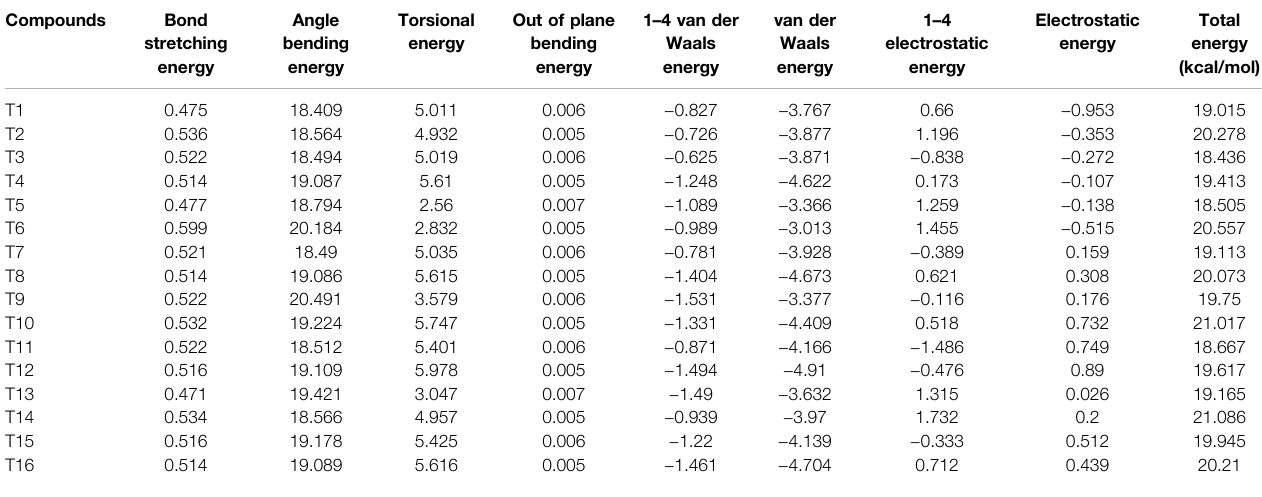
TABLE 2 | Various energy data of the target compounds from energy minimization via Sybyl.